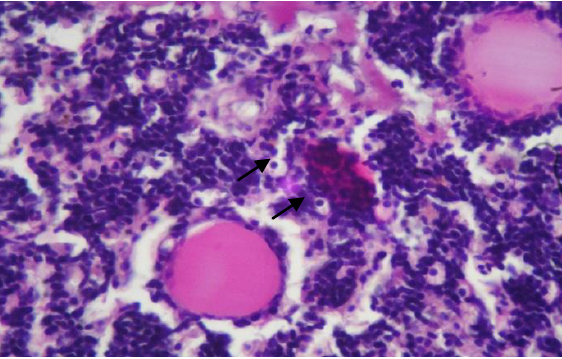
Figure, 4: Head of kidney in fish two large thyroid follicles of fish. Notice many clear cells lie near the follicles (arrows) (40X. PAS.